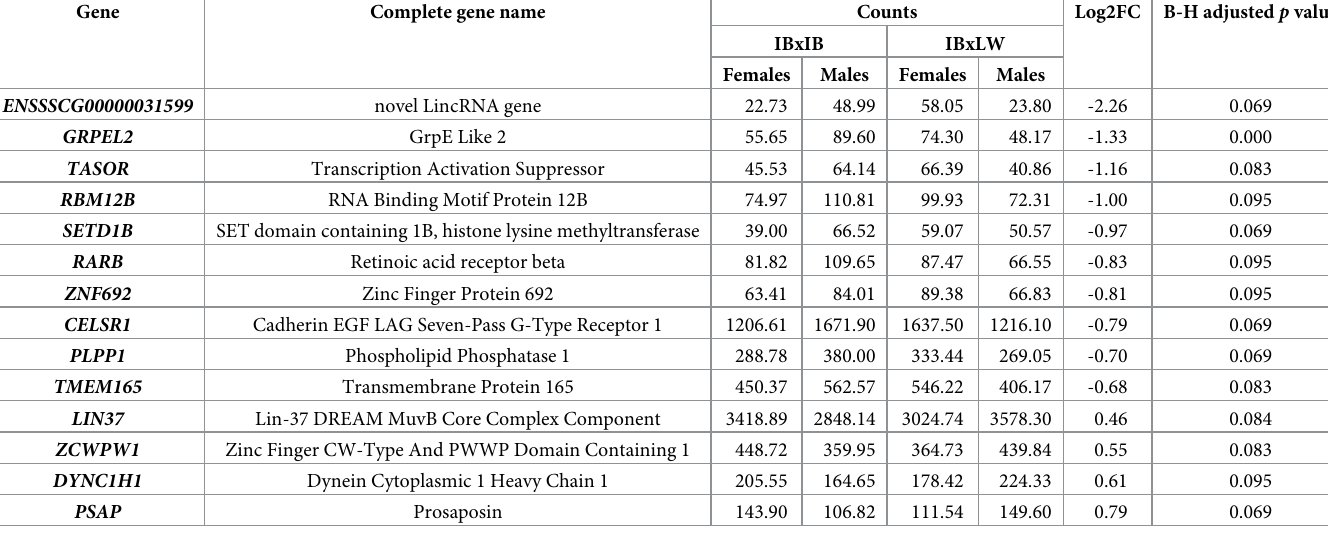
Table 4. Genotype by sex significant (B-H adjusted p value < 0.1) qualitative interactions in gene expression calculated with DESeq2 from hypothalamic transcrip- tome data of 60 days-old pure Iberian and Iberian x Large White crossbred